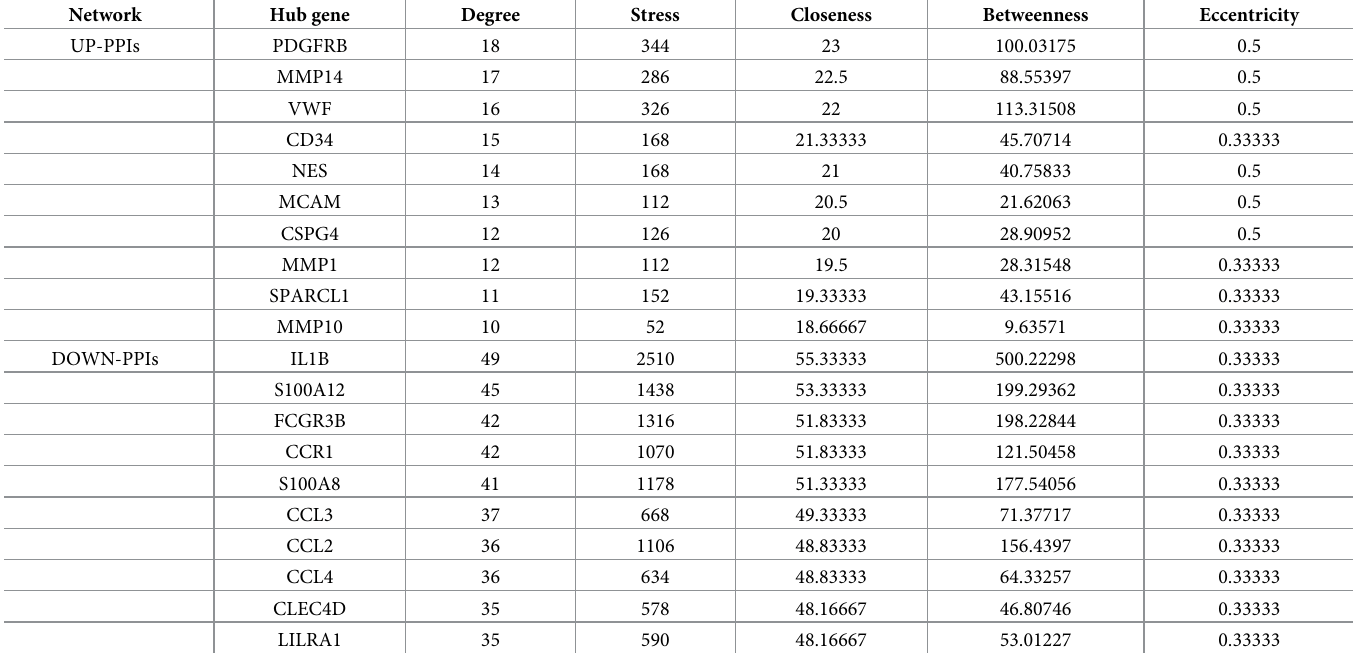
Table 4. Topological results for the first 10 hub